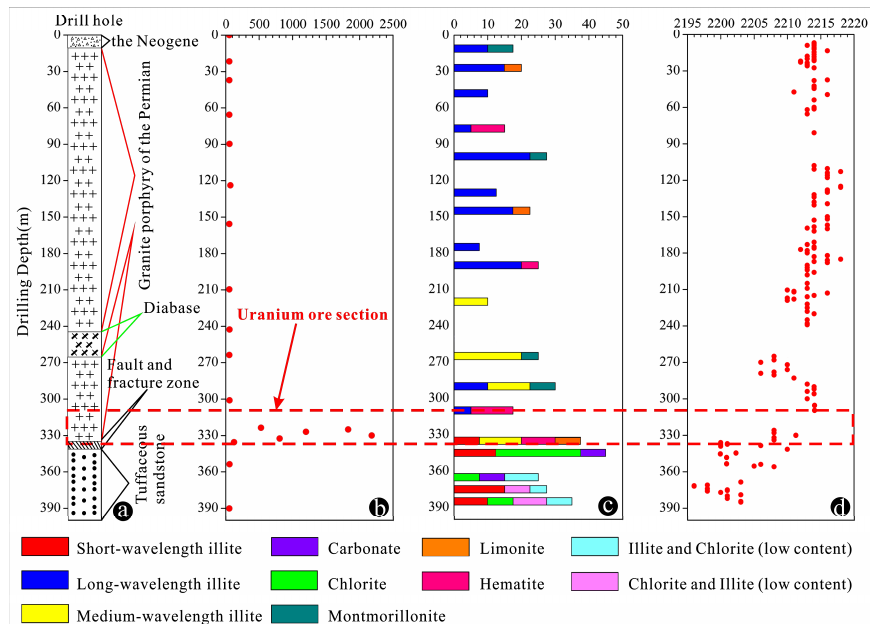
Figure 7. ( a ) Geological sketch map of drill hole ZK5630-1 (the numbers on the left are the depths of the drill hole). ( b ) Map of the measured U content (ppm) in the drill core (the numbers at the top are the U γ values, and the numbers on the left are the depths of the drill hole). ( c ) Vertical distribution log of the alteration minerals in the drill core and the variations in their intensities (the numbers at the top are the number of identified alteration minerals) with depth. In the same histogram, the variations in the types of alteration minerals with depth and the intensity of the alteration are indicated by the intensity of the color. ( d ) Chart of the absorption-peak wavelength (1000–2500 nm) of illite at 2200 nm (the numbers at the top are absorption-peak wavelength of illite at 2200 nm, and the numbers on the left are the depths of the drill